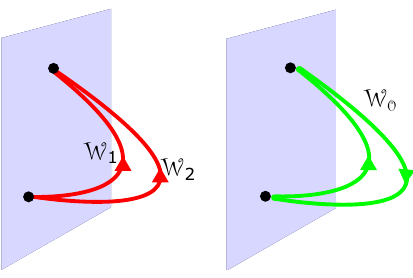
Figure 3 . Left: two Wilson lines W 1 and W 2 at the same boundary point. Right: closed Wilson loop W o = W 1 W (cid:0) 1 2